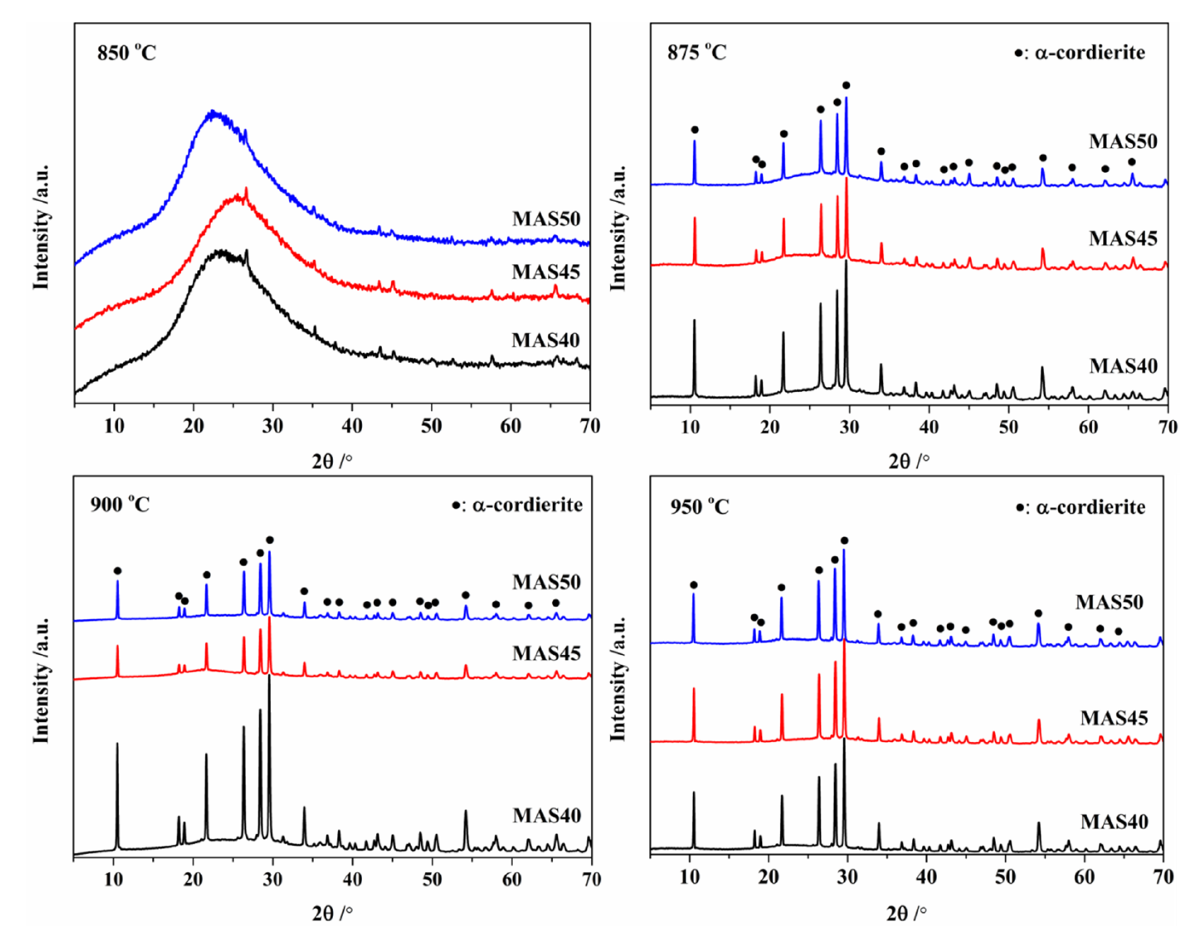
Figure 2. XRD patterns of the glass-ceramics at different sintering temperatures.